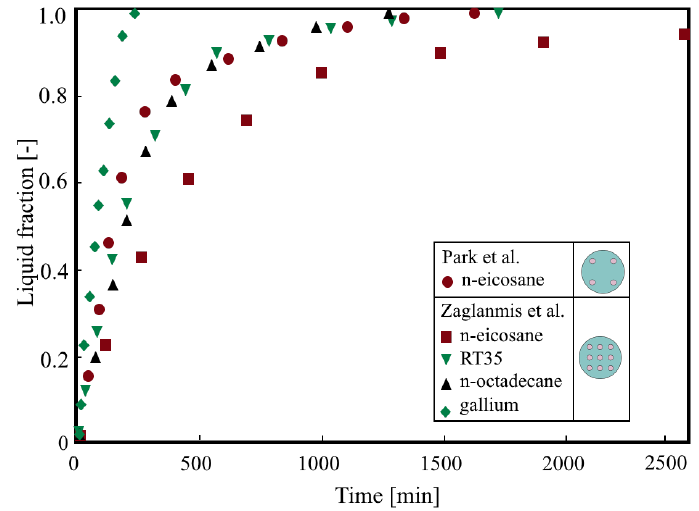
Figure 13. Liquid fraction distribution for MTH TESU [97,108].